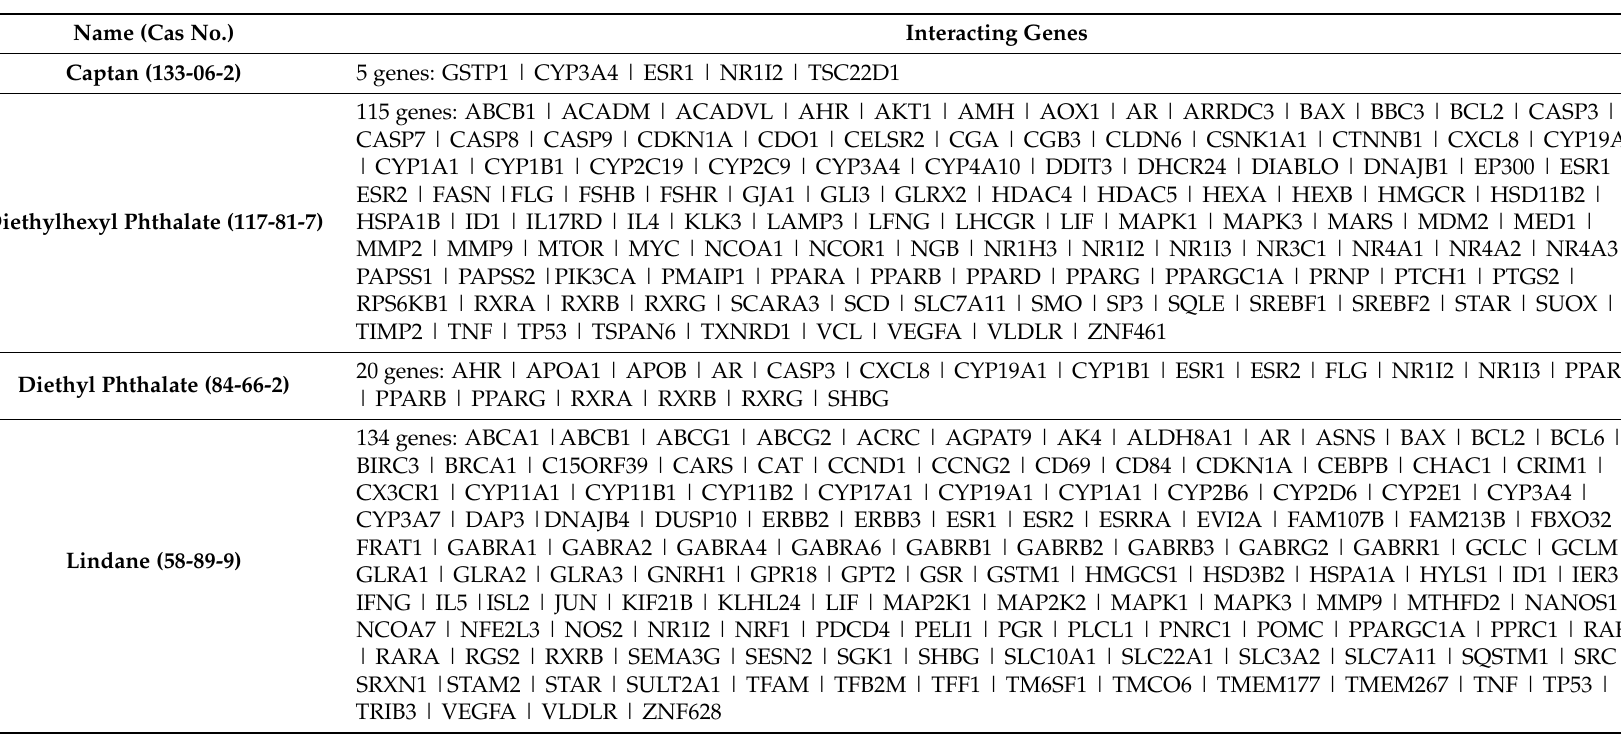
Table 1. Four EDCs and their interacting genes searched in